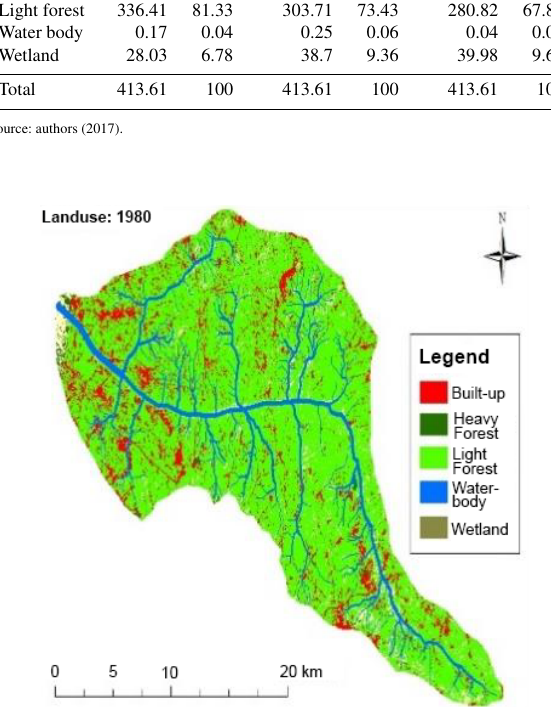
Figure 2. Landuse/land cover pattern in 1980.